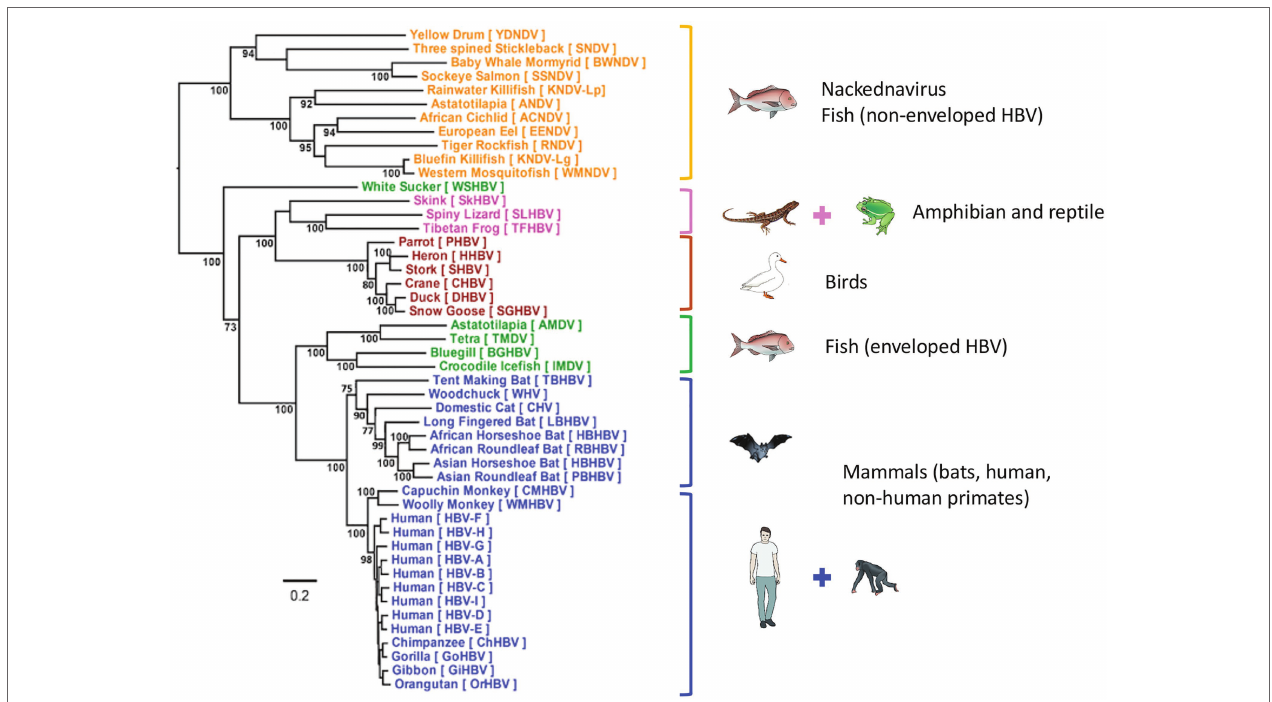
FIGURE 2 | Phylogenetic tree of Hepadnaviridae . Phylogenetic analysis of representative hepadnavirus full-length genome sequences from each of the host species known to harbor hepatitis viruses including the HBV genotypes from humans. In general, all HBVs from the same host species cluster together with strong bootstrap support (>80%; with the exception of WSHBV, an enveloped HBV from fish). Based on the available HBV genome sequences, the enveloped and non-enveloped HBVs had distinct evolutionary histories following divergence from their most recent common ancestor (MRCA). The enveloped HBVs are further divided into two major clusters, mammals and fish and amphibians, reptiles, and birds sharing another MRCA. Of these genome sequences, 34 were sourced from GenBank and 14 were annotated sequences from the supplementary data files of Lauber et al. (2017), representing new isolates. The maximum-likelihood (ML) phylogenetic tree was estimated using IQ-TREE v1.6.5 (Nguyen et al., 2015), which is packaged with ModelFinder (Kalyaanamoorthy et al., 2017) and UFBoot (Hoang et al., 2018). Clade support was assessed using 1,000 pseudo replicates generated with the UFBoot non-parametric bootstrap procedure. Branch lengths are scaled to the number of nucleotide substitutions per sequence site. (From (Revill et al., 2020); modified, with permission from the